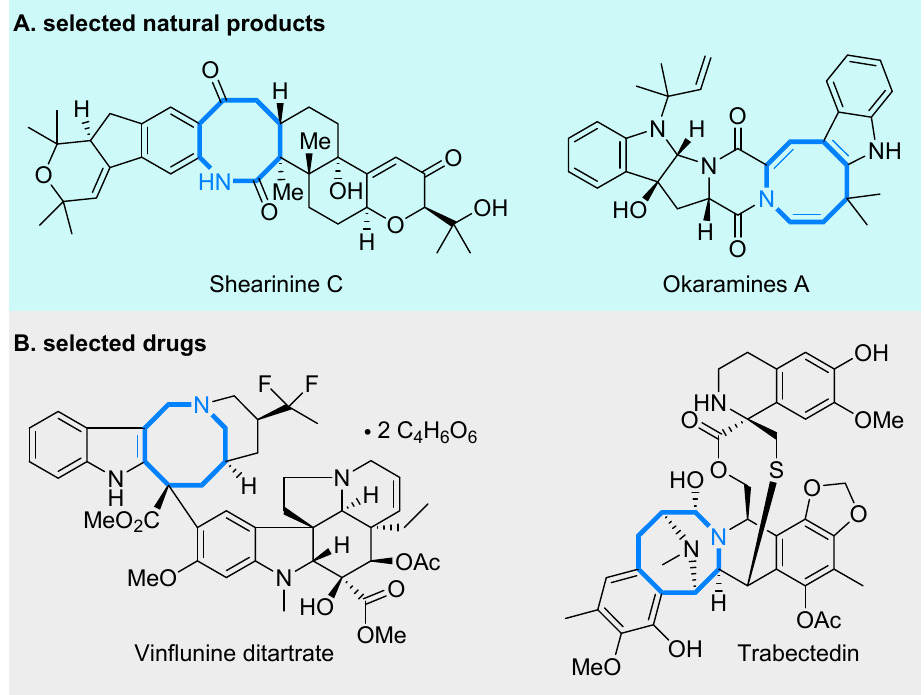
Figure 1. Selected examples of biologically important molecules with a nitrogen-containing medium-sized ring .